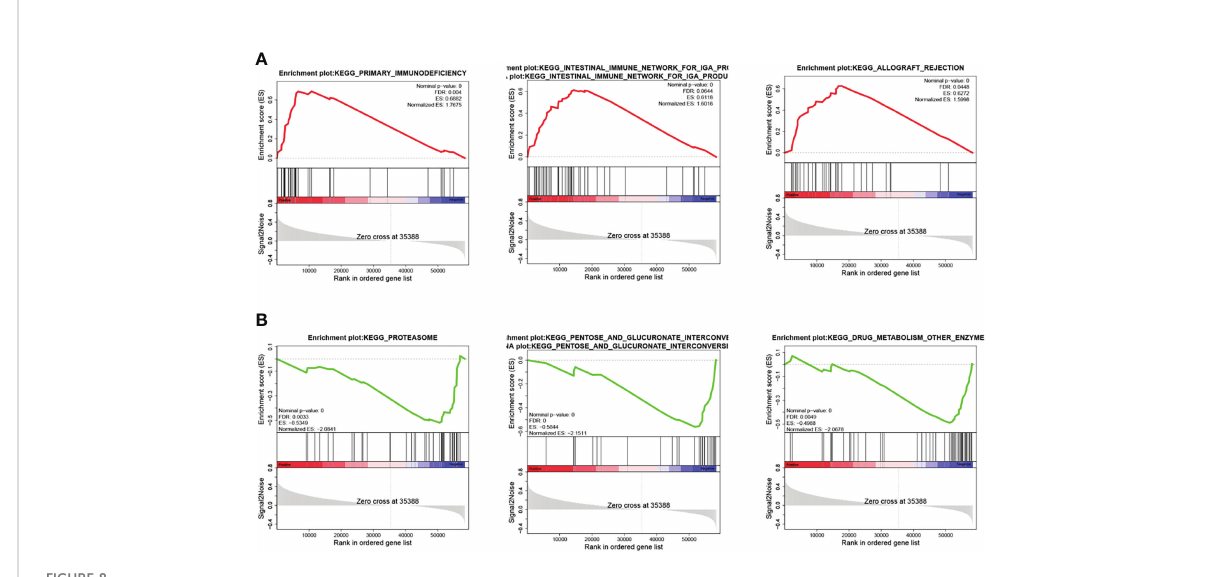
FIGURE 8 Pathway enrichment of VAMP2. (A, B) : KEGG pathway enrichment in high- and low-expression groups, respectively; hallmark pathway enrichment in high- and low-expression groups, respectively.